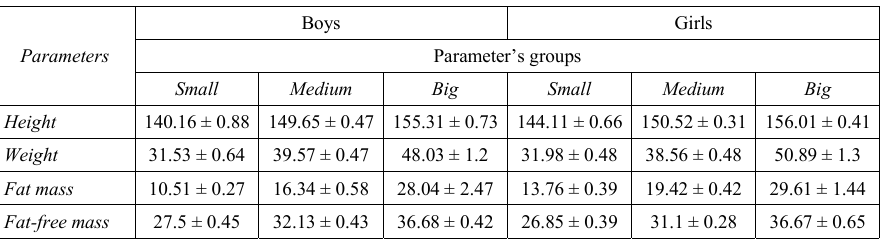
Table. Mean values (± standard error of mean) of school- children’s height, weight, fat mass and fat-free